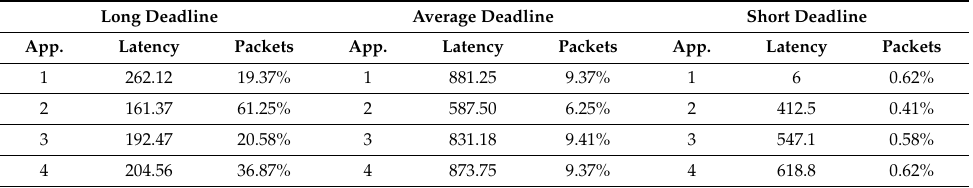
Table 6. Mesh topologies with 15